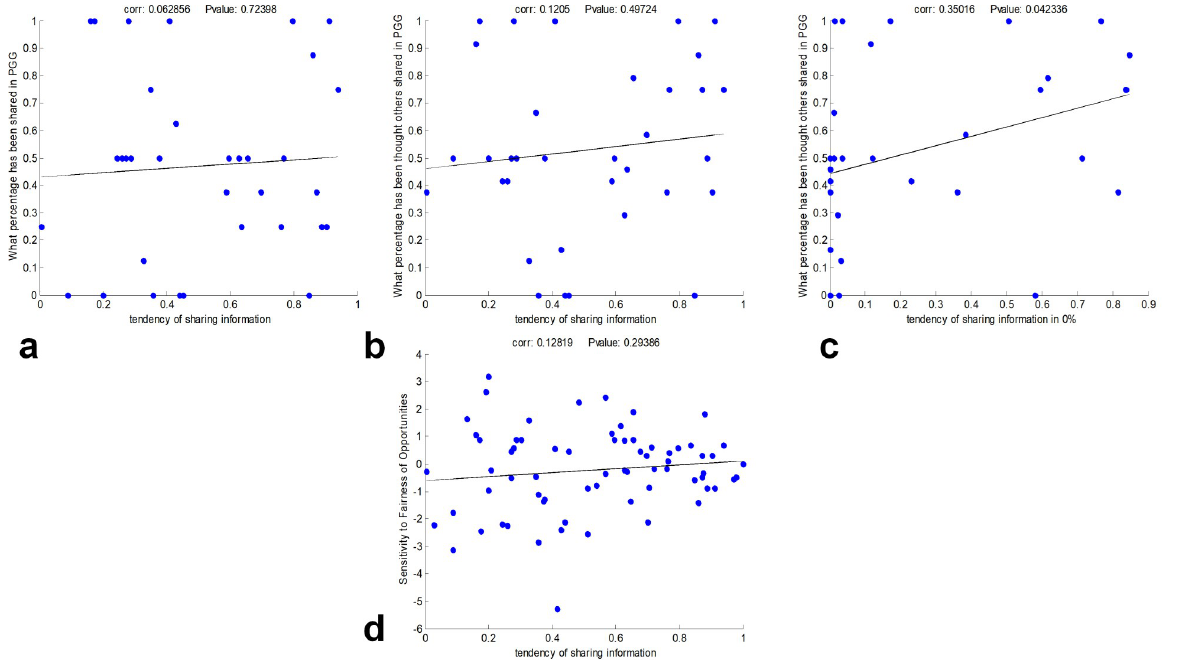
Fig 3. Information sharing and behavioral factors a) tendency of sharing information and subjects cooperation in Public Goods Game (PGG) b) tendency of sharing information and subjects’ beliefs about others cooperation in PGG c) tendency of sharing information in zero benefit and subjects’ belief about others cooperation in PGG d) tendency of sharing information and sensitivity to the fairness of